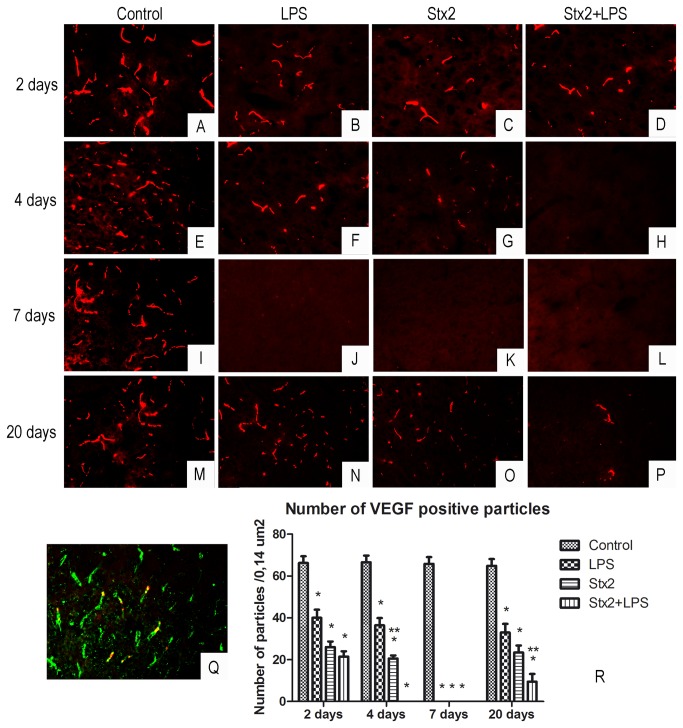
Changes in the expression of VEGF.Micrographs A, E, I and M: basal expression of VEGF with saline treatment; B, F, J and N: LPS treatment; C, G, K and O: Stx2 treatment; D, H, L and P: Stx2+LPS treatment; at two, four, seven and twenty days after the respective treatment. Stx2+LPS fully decreased VEGF expression after four days of treatment until day seven (H and L). LPS (J) or Stx2 (K) treatment fully decreased VEGF expression as from day seven. Micrograph Q shows co-localization of VEGF and glycocalyx particles bound to lectins in the endothelium. Stx2+LPS significantly decreased VEGF expression as compared to LPS or Stx2 treatment (R) (p <0.001). *: significant differences between the treated and saline groups. **:significant differences between Stx2+LPS and Stx2 treatments (p <0.001).